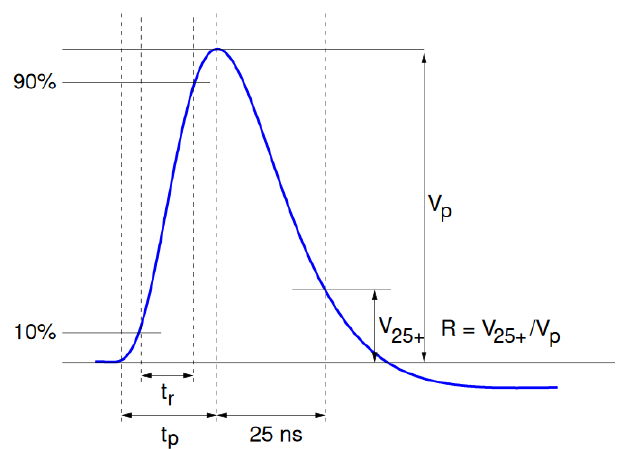
Figure 3. The signal pulse shape seen at the output of the front-end. The amplitude of the signal is directly proportional to the charge in the channel